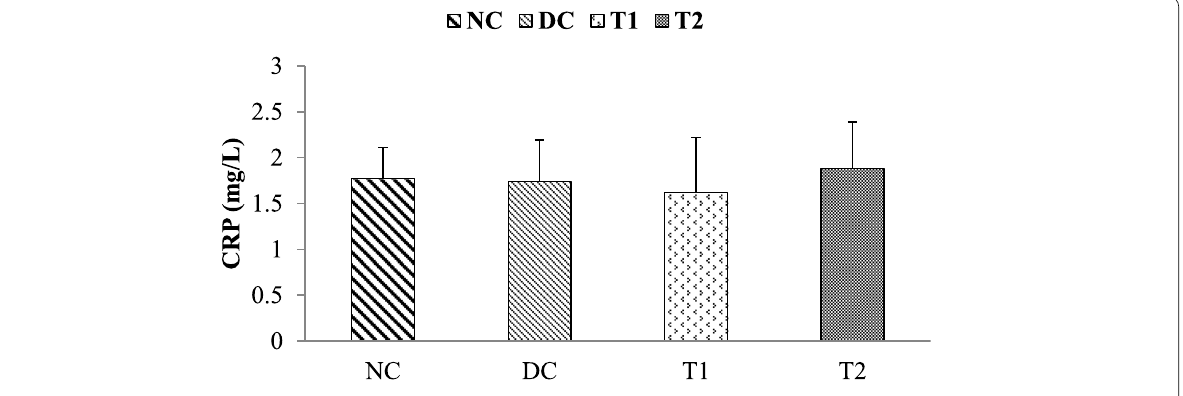
normal control, DC disease control, T1 probiotic fermented milk withWPC and = = =